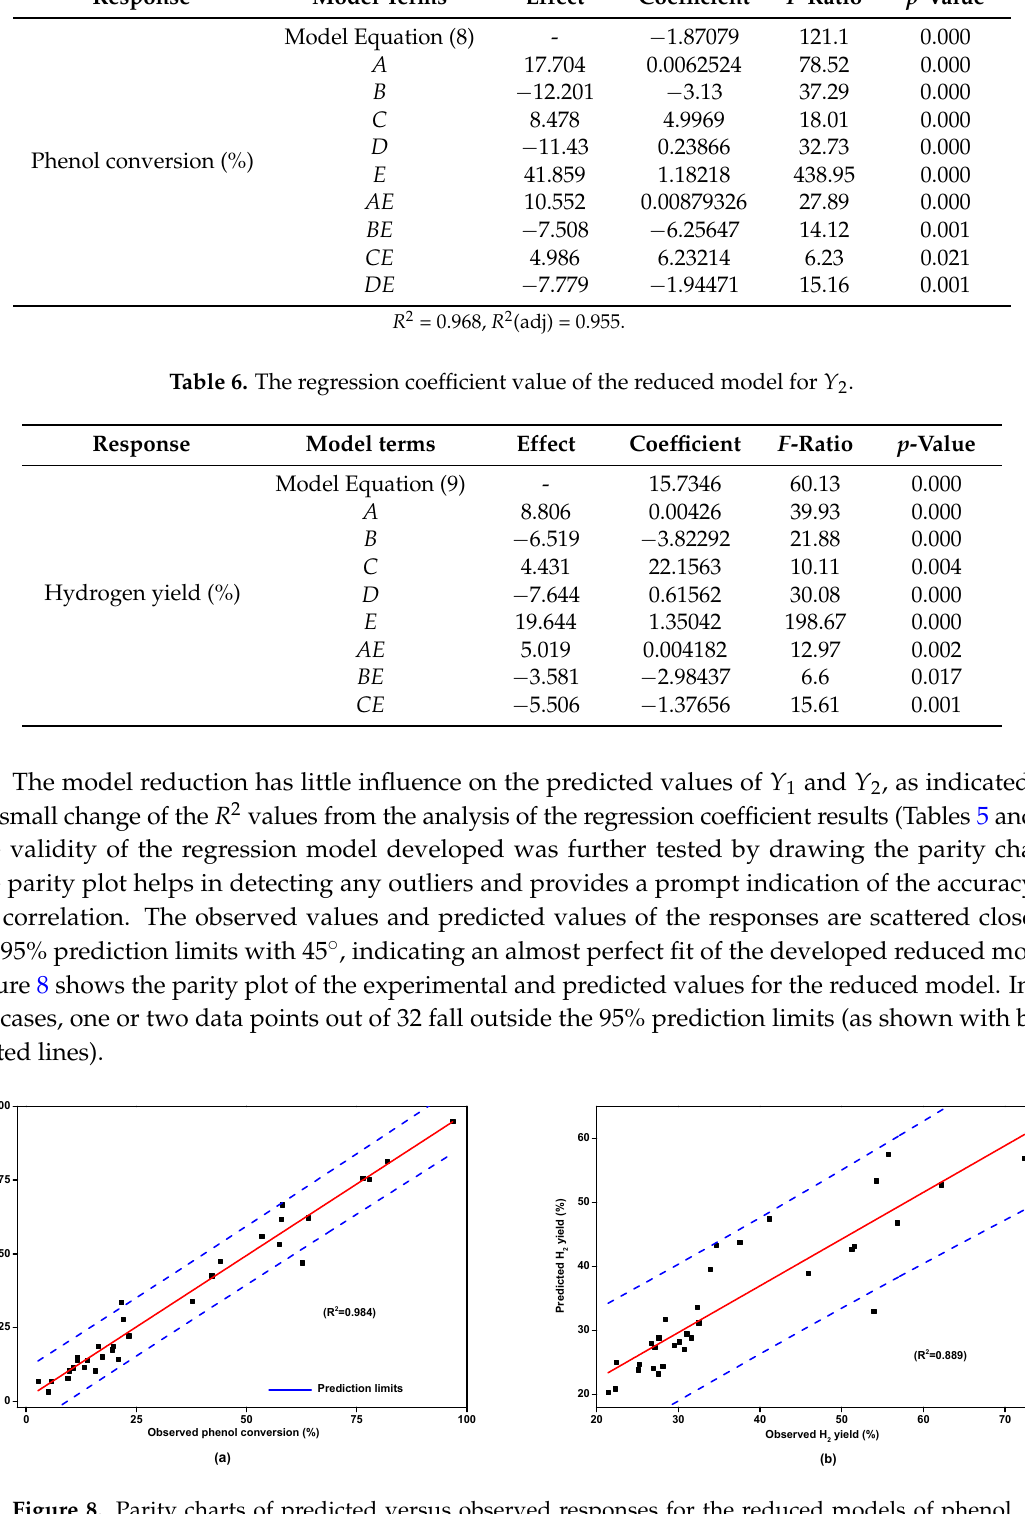
Figure 8. Parity charts of predicted versus observed responses for the reduced models of phenol conversion ( Y 1 ) ( a ) and hydrogen yield ( Y 2 ) ( b ) with a 95% prediction band.